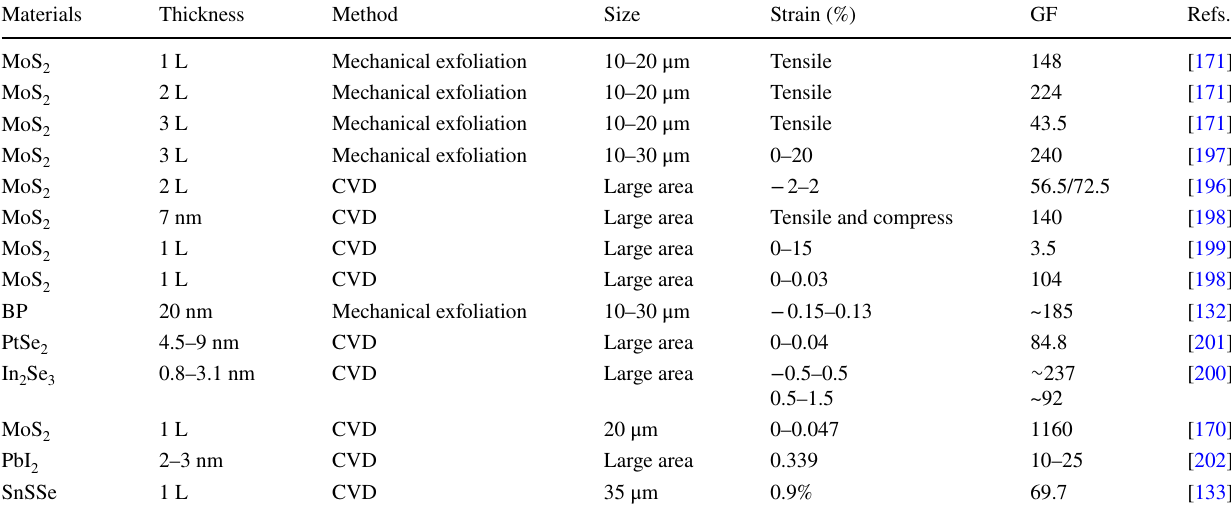
Table 2 A list of strain sensor based on 2D materials and their properties